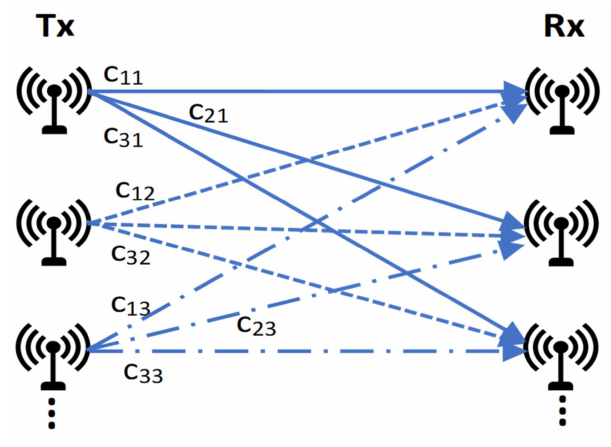
Figure 4. MIMO system